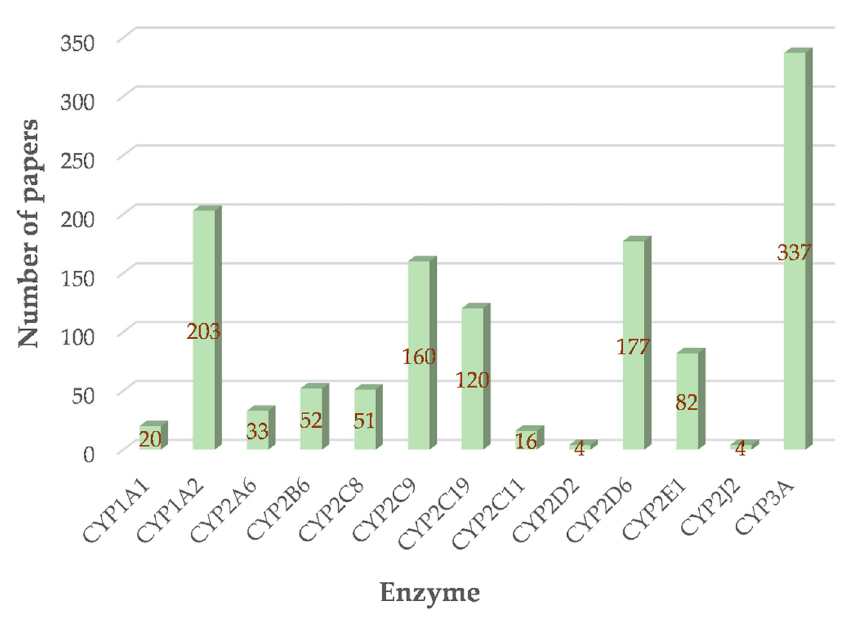
Figure 4. Number of papers reporting the modulation effects of natural resources on each CYP450 enzyme. Table 1. Commonly used CYP450s and their substrate in probe assays along with the HPLC-MS